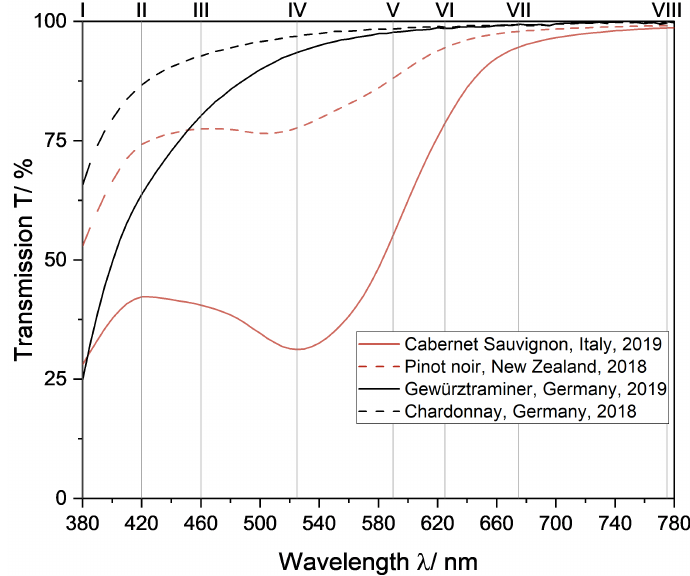
Figure 3. Transmission spectra of two red wines and two white wines to illustrate the choice of supporting points for color determination based on interpolation of transmission spectra. The position of supporting points is marked by numbers (I—VIII, Table